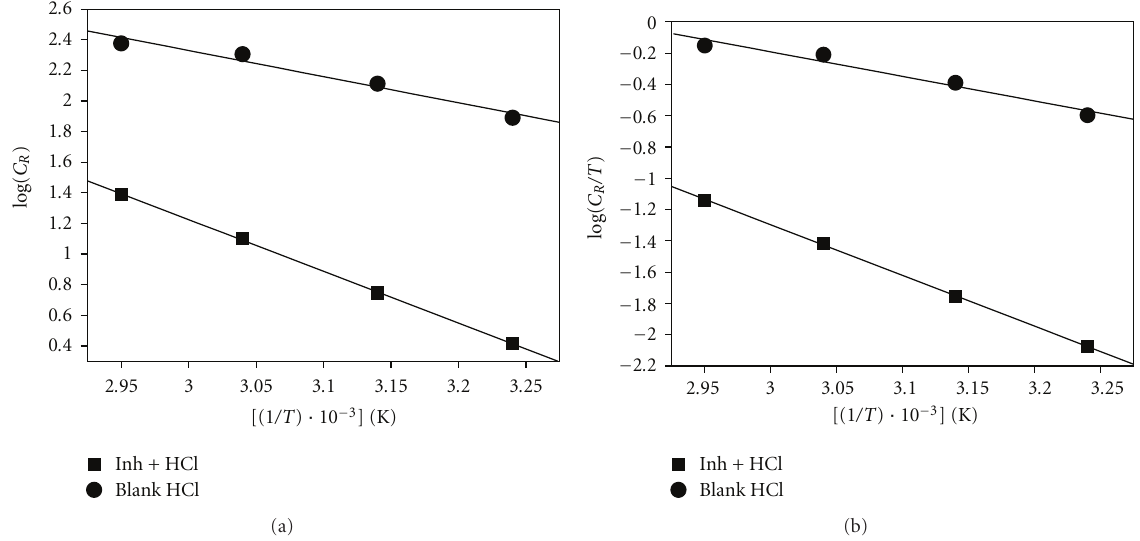
Figure 2: Adsorption isotherm plots for (a) log C R versus 1 /T and (b) log ( C R /T ) versus 1 /T